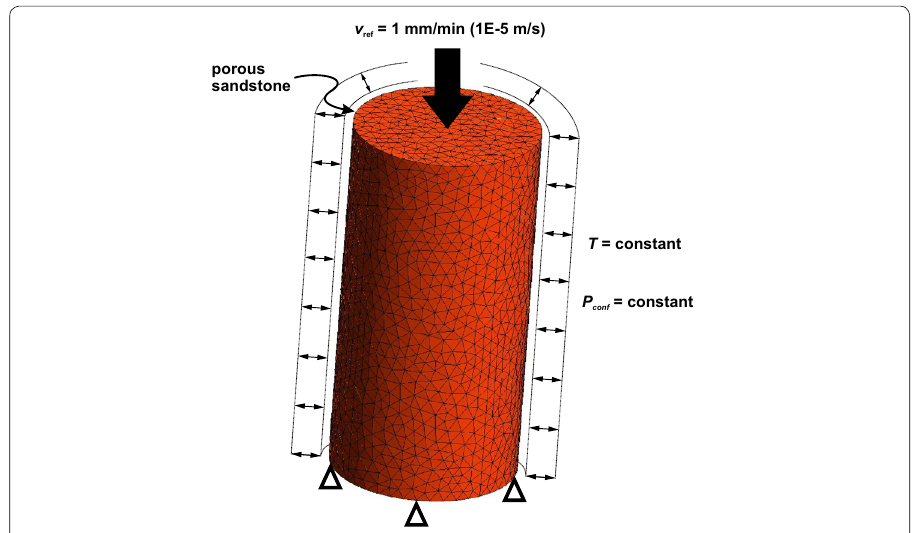
Fig. 3 The applied FE mesh and applied boundaries for the numerical